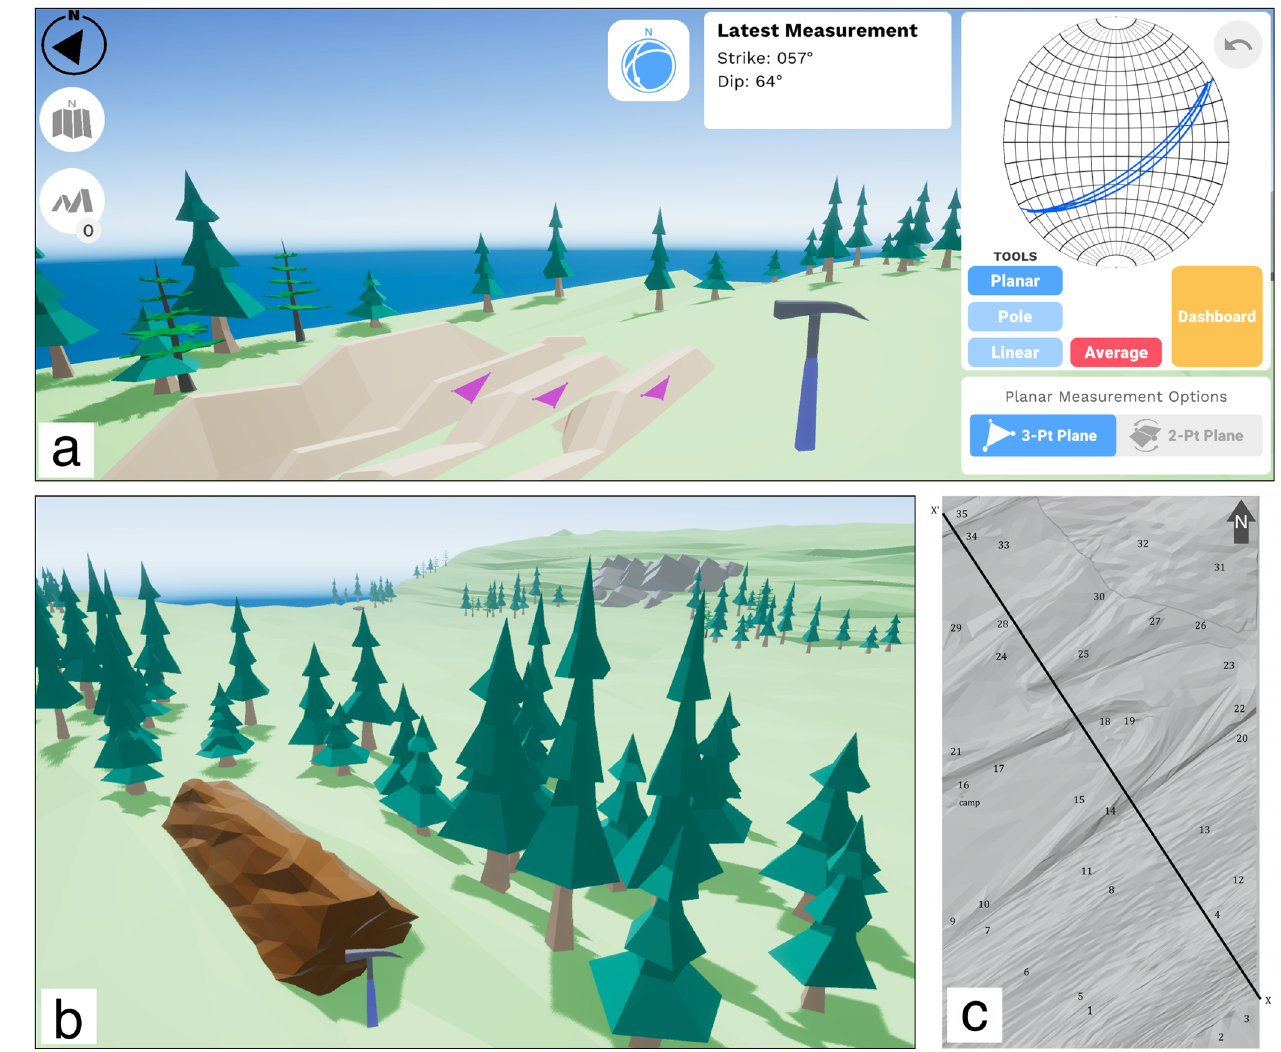
Figure 3. Fictional virtual field experience. (a) Planar measurements (magenta triangles) are taken on the bedding surfaces of a sandy colored outcrop with the orientation data projected into a stereonet and printed on-screen. When the user clicks on the rock hammer, an informational canvas (not included in figure) opens to display photographs and other information about the outcrop. (b) A screenshot from a different part of the terrain shows two outcrops, i.e., a brown outcrop without bedding (foreground) and a blocky gray outcrop in the background. (c) The hillshade-style base map provided to students includes the approximate locations (and numbers for organization) of outcrops and the position of X − X (cid:48) cross section line for interpreting the subsurface during/after the map